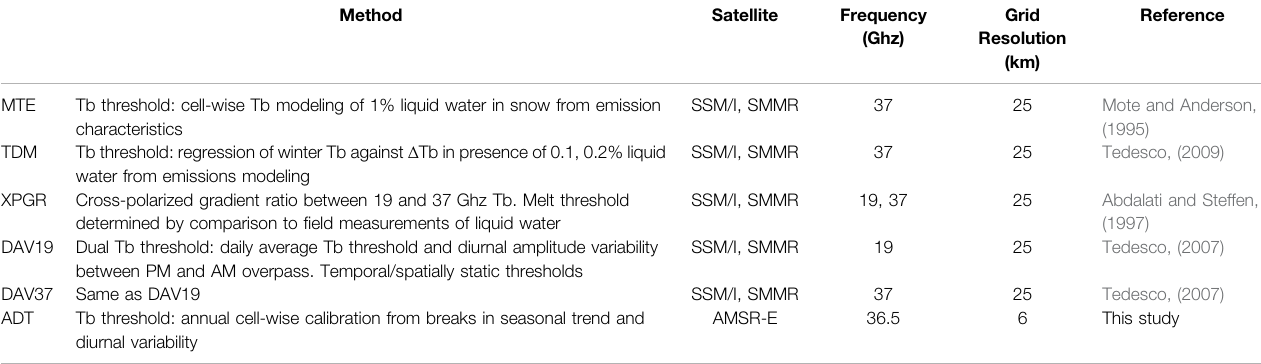
TABLE 1 | Summary of tested microwave-based surface melt